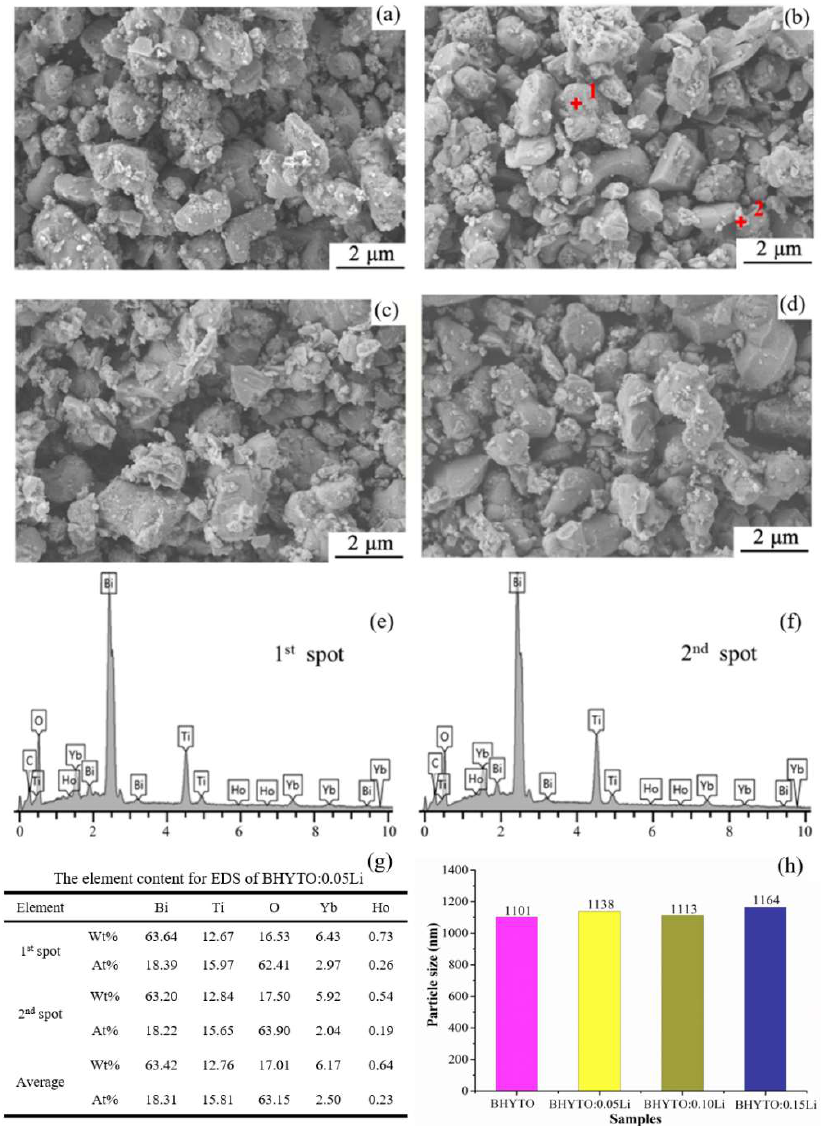
Figure 2. SEM of the BHYTO: x Li samples with x values equal to ( a ) 0, ( b ) 0.05, ( c ) 0.10, ( d ) 0.15, respectively, and ( e ), ( f ) EDS of 1 st and 2 nd spots in Figure 2b, ( g ) the elemental content in the samples of the BHYTO: 0.05Li samples, and ( h ) histogram of particle size for the samples.